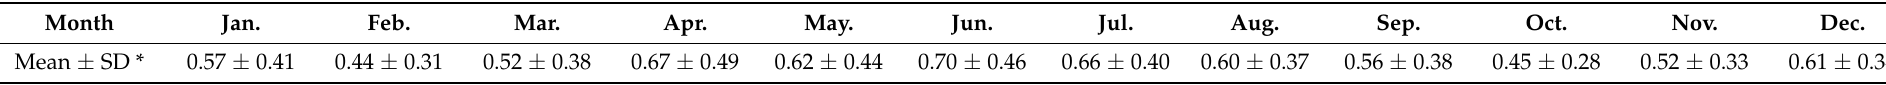
Table 2. Mean and corresponding standard deviations of mean absolute error (MAE) values (computed using Equation (10)) for each month. Note that MAE denotes the average difference in temperature between restored and ground-truth images (unit: Celsius, ◦ C) Month Jan. Feb. Mar. Apr. May. Jun. Jul. Aug. Sep. Oct. Nov. Dec.